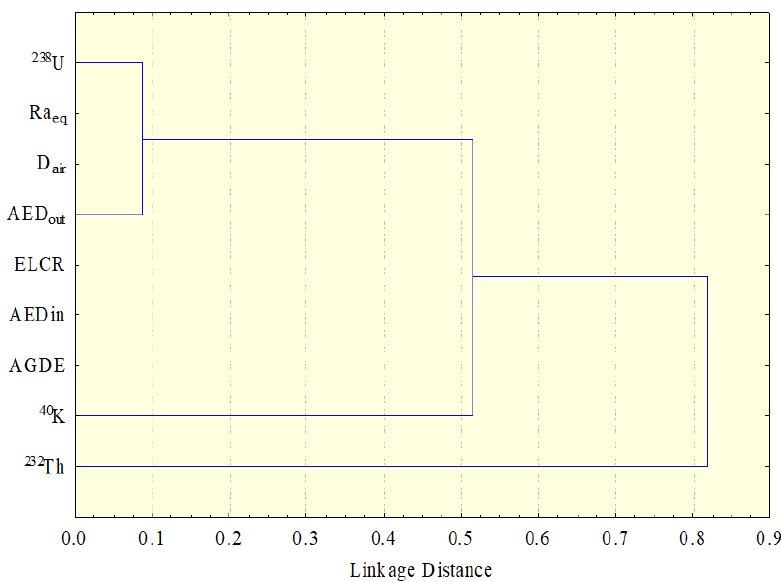
Figure 10. Dendrogram showing the clustering of